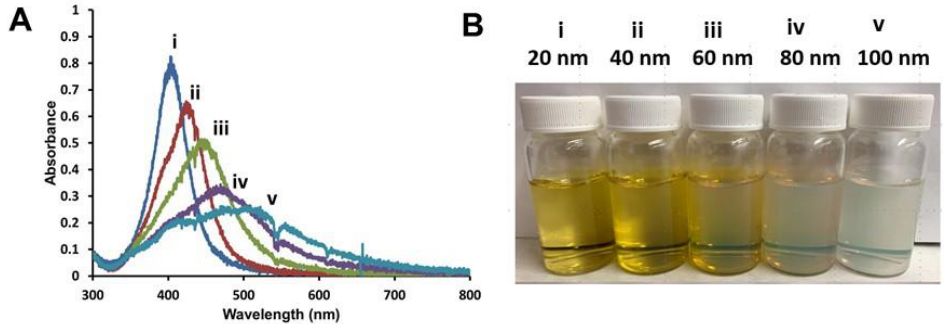
Figure 1. ( A ) Representative UV–Vis spectra of purified spherical Ag–SOA–PC–HT at the same concentration (6 mg Ag/L) and ( B ) photographs of ( i ) 20 nm, ( ii ) 40 nm, ( iii ) = 60 nm, ( iv ) 80 nm, and ( v ) 100 nm nanoparticles in